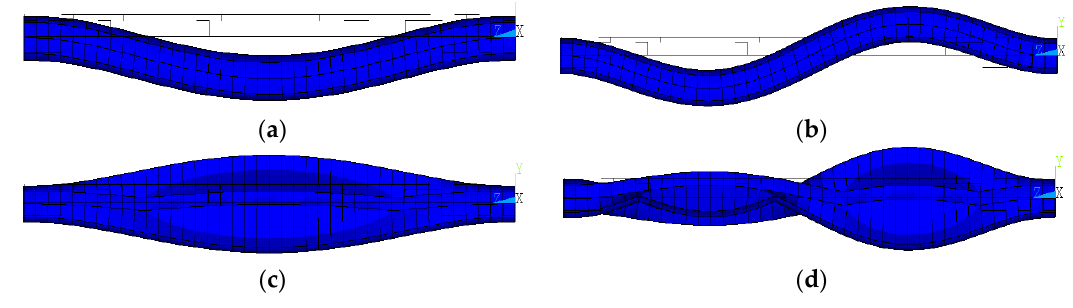
Figure 2. The first four mode shapes. ( a ) The 1st mode shape; ( b ) The 2nd mode shape; ( c ) The 3rd mode shape; ( d ) The 4th mode shape.